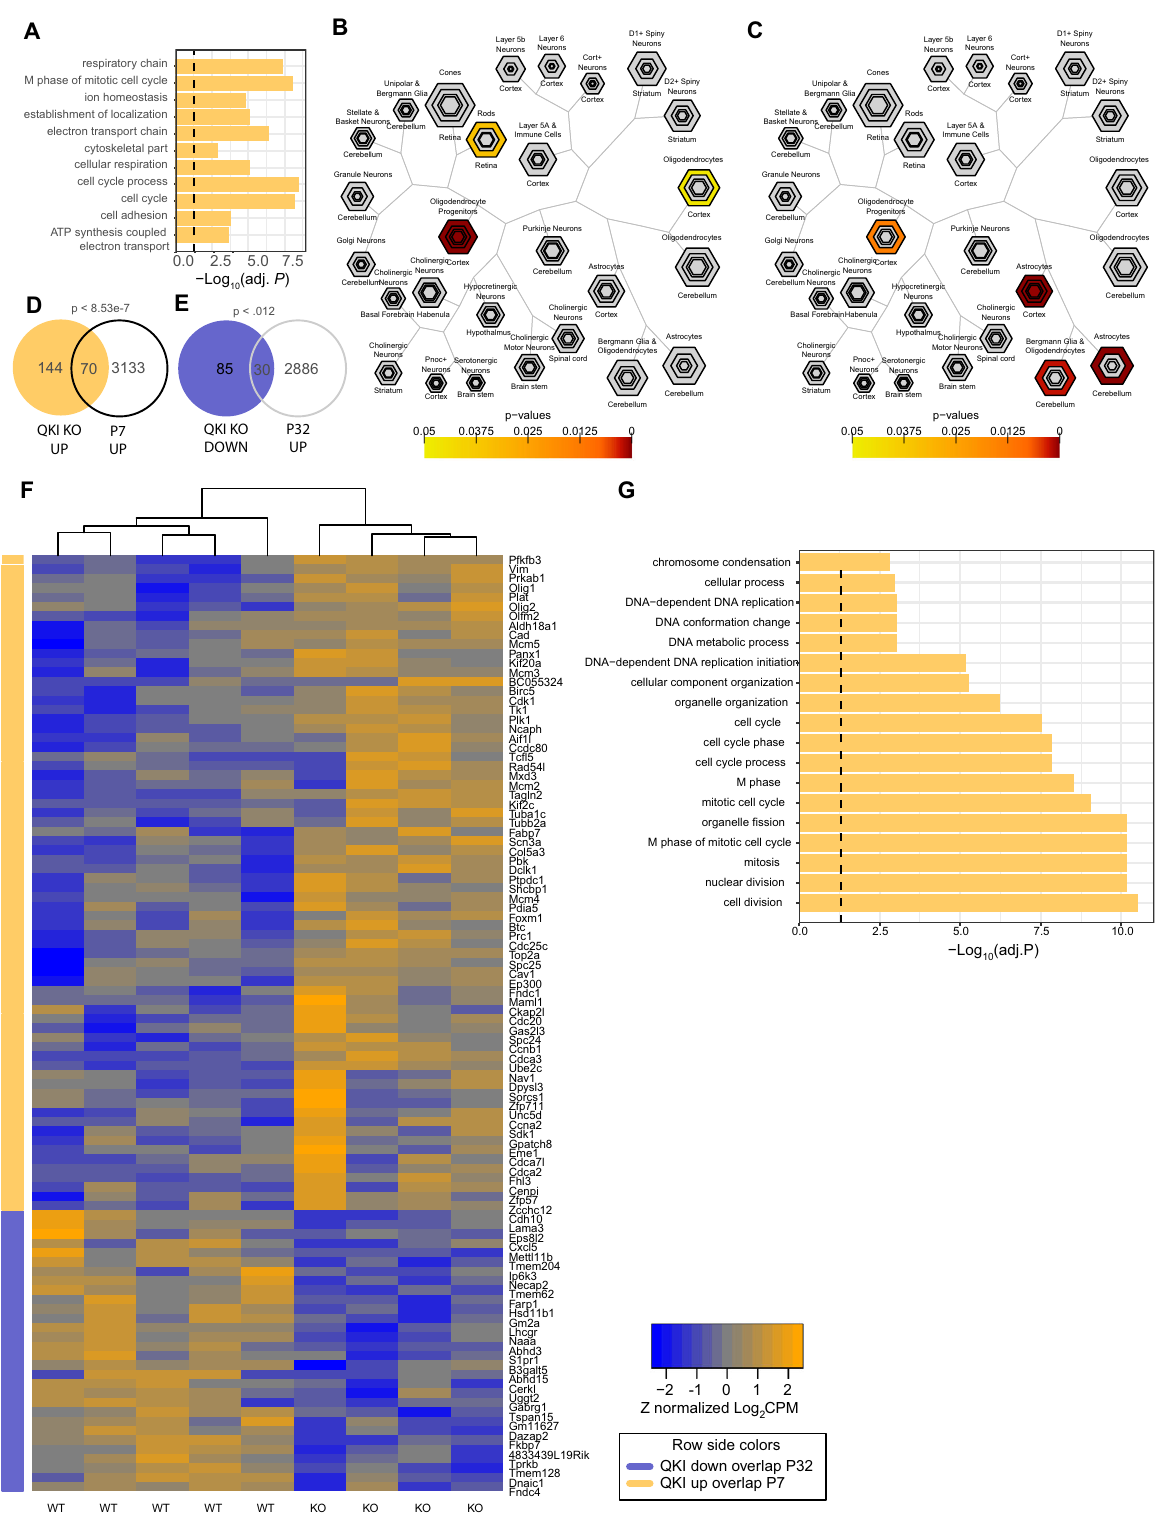
Fig. 5 QKI deletion delays a subset of astrocyte transcript maturation. A Gene Ontology analysis of biological processes enriched by QKI loss reveal increased mitochondrial and cell proliferation. B CSEA of transcripts increased when QKI is deleted are disproportionately found in oligodendroglial progenitor cells. Cell-type-speci fi c data is FPKM from ref. 21 (brainrnaseq.org). C CSEA of transcripts decreased when QKI is deleted are disproportionately found in adult astrocytes. Cell-type-speci fi c data is FPKM from ref. 21 (brainrnaseq.org). D Transcripts increased when QKI deleted contain proportionally more P7 astrocyte transcripts. E Transcripts decreased when QKI deleted contain proportionally more P32 astrocyte transcripts. F Heatmap of transcripts both modulated by QKI mutation and differentially expressed between P7 and P32. G The 70 transcripts from D are highly enriched in cell cycle-related biological processes. The 30 transcripts from E did not signi fi cantly map to a de fi ned biological process.